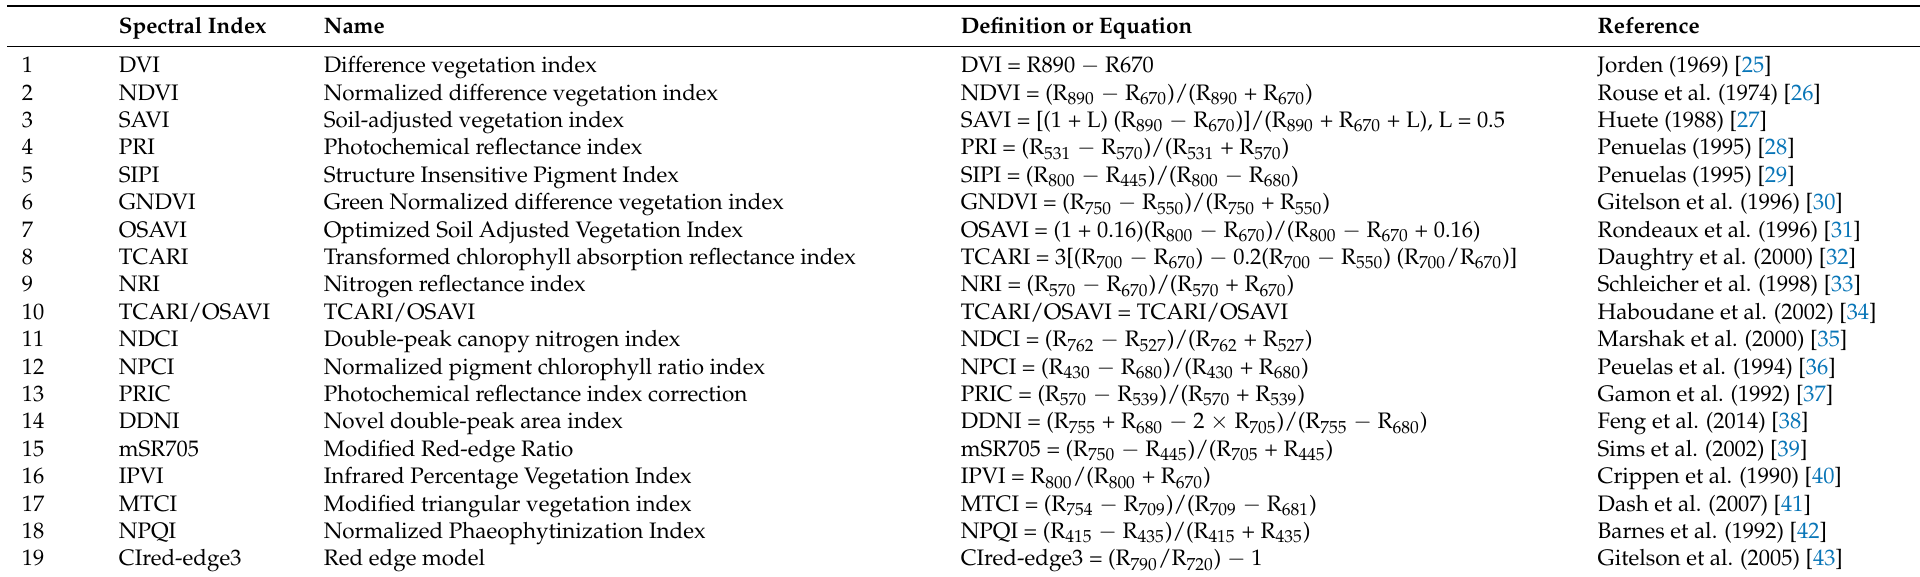
Table 2. Summary of selected spectral parameters reported in the